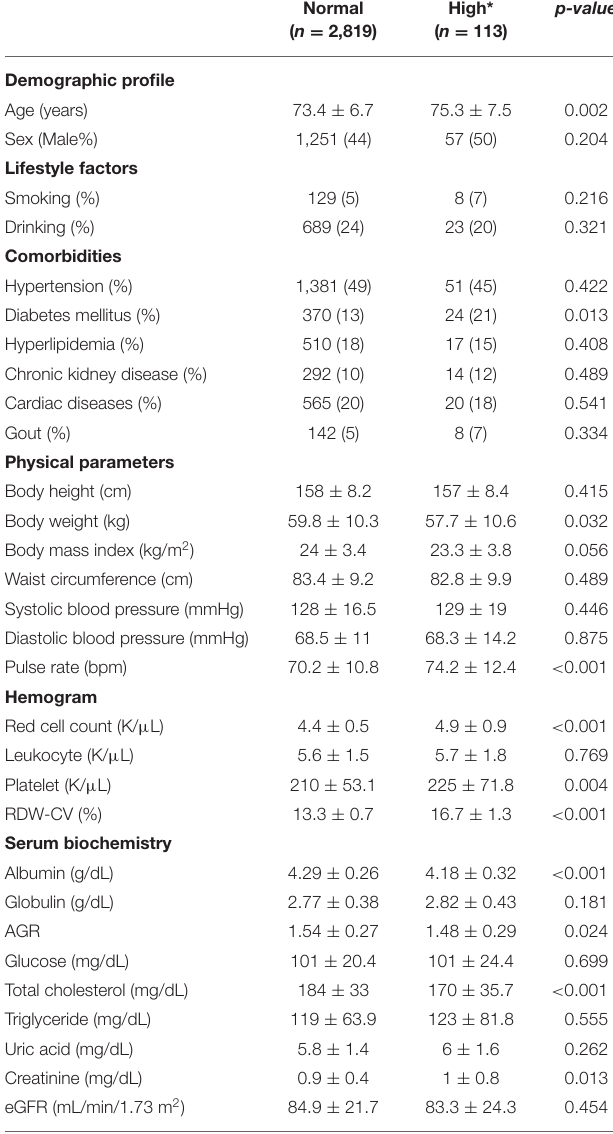
TABLE 1 | Participants’ clinical features based on RDW